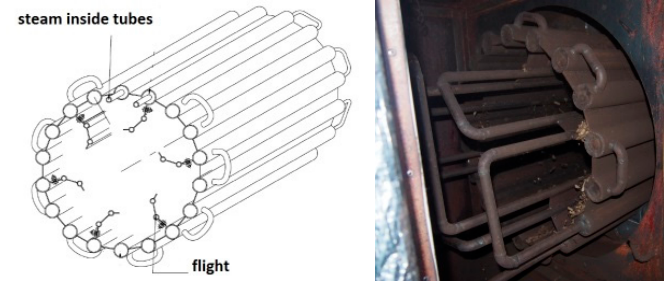
Figure 6. The drum configuration.